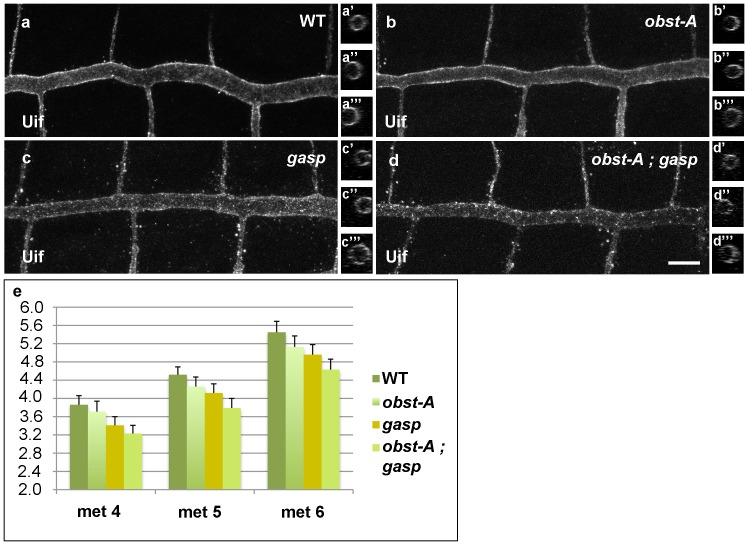
Lumen diameter expansion requires Obst-A and Gasp.(a–d) Confocal microscopy projections of the trachea of wild-type (a–a′′′), obst-A (b–b′′′), gasp (c–c′′′) and obst-A; gasp (d–d′′′) embryos labeled with the apical marker Uninflated (Uif) at stage 16.1. Inserts display y-z projections of the DT tubes from 3 different metameres. a′, b′, c′ and d′ inserts are from the middle of metamere 4, a′′, b′′, c′′ and d′′ from the middle of metamere 5 and a′′′, b′′′, c′′′ and d′′′ from the middle of metamere 6. Scale bar: 10 µm (e) Quantification of tracheal diameter of wild-type, obst-A, gasp and obst-A; gasp embryos at stage 16.1. The graph shows diameter measurements of three metameres: 4, 5 and 6. Number of embryos used for measurement of each genotype n = 6. The y-axis represents the diameter in micrometers. Tube diameter values in all mutant embryos were significantly different (p<0.05) from the wild-type by a two-tailed distribution unpaired Student’s t-test.